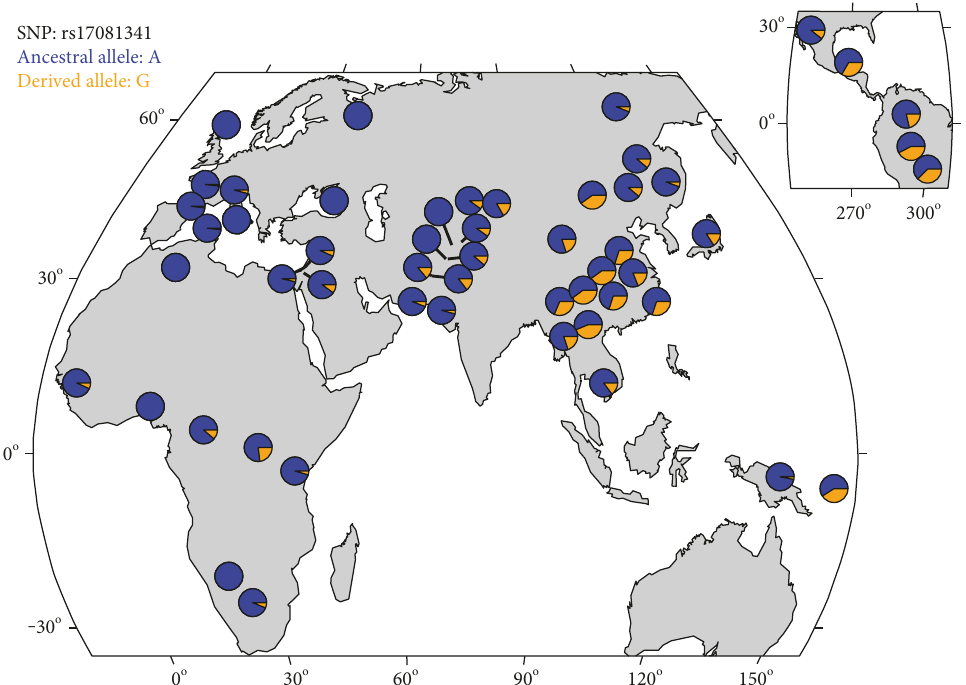
Figure 3: Allele frequency distribution of the SNP rs17081341 in the Human Genome Diversity Panel dataset.